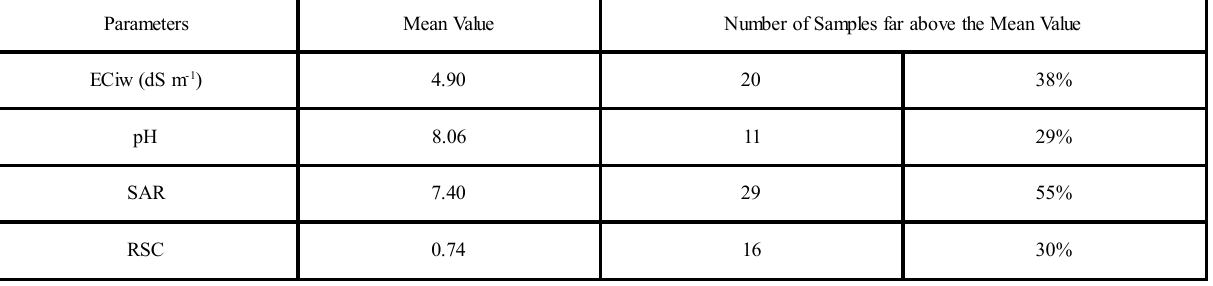
TABLE 3. PERCENTAGE OF SAMPLES FALL ABOVE MEAN VALUE OF EC Parameters Mean Value Number of Samples far above the Mean Value